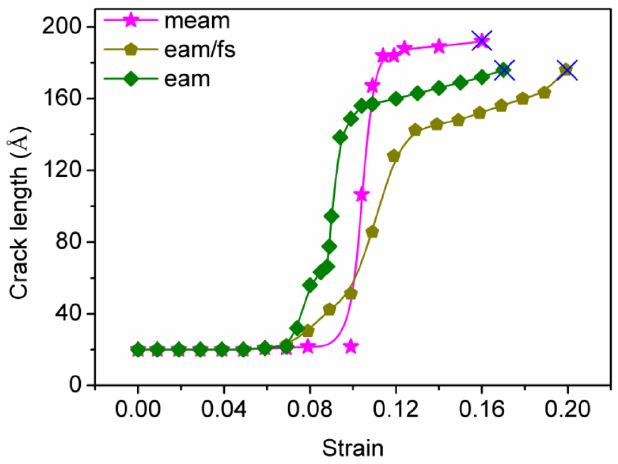
Figure 8. The crack length–strain curve of single-crystal Ni at different styles of potentials. The symbol ‘ × ’ denotes the fracture point of the tensile model.